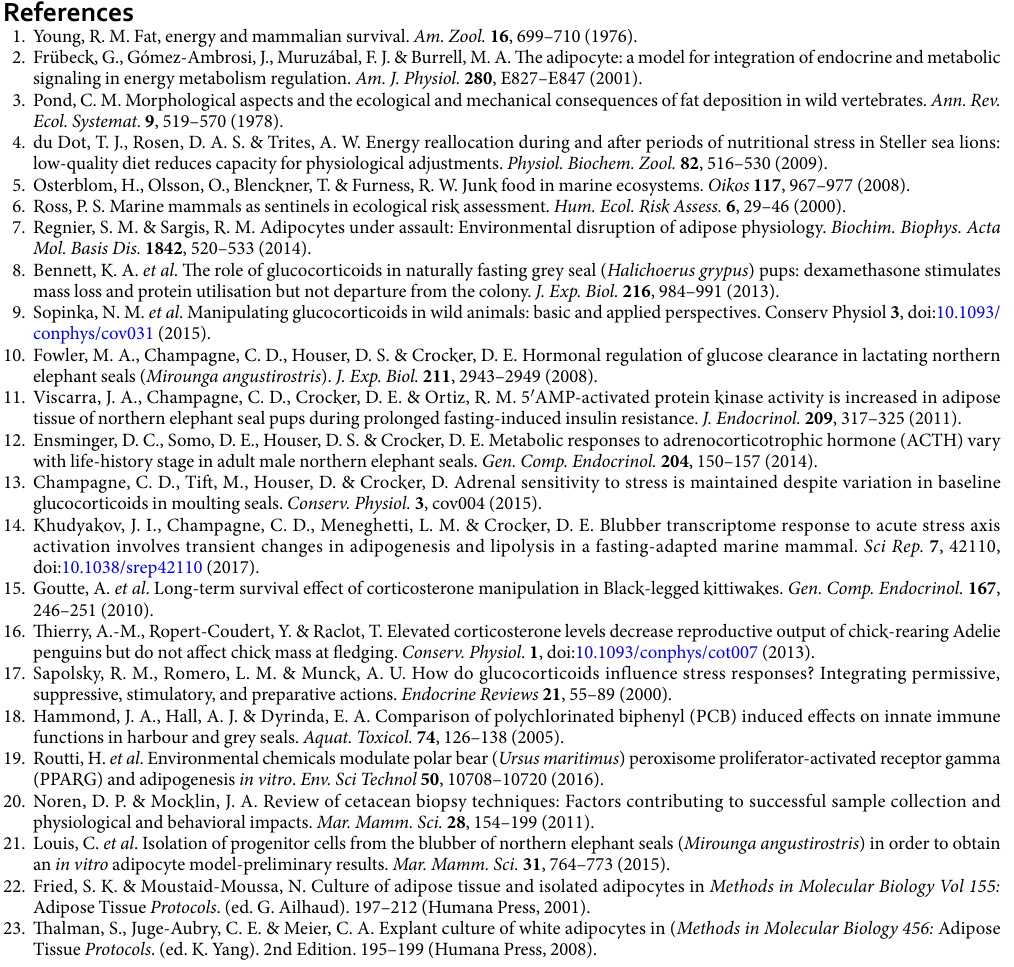
correlations between all rates of removal and accumulation. Glycerol and lactate accumulation rates and gene expression values were log transformed for